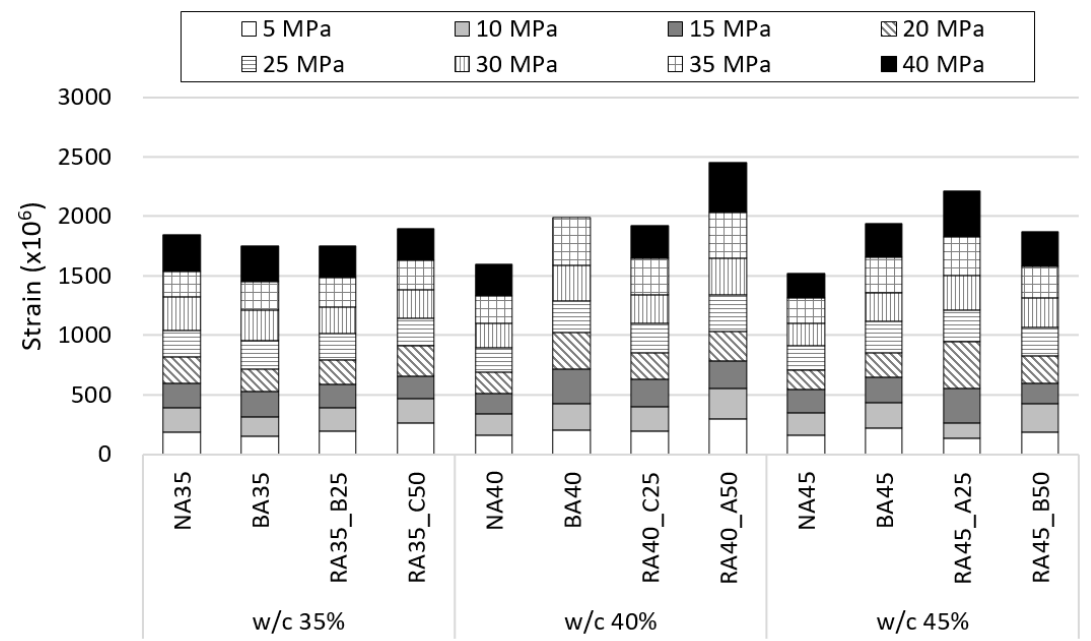
Figure 8. Strain of concrete specimens according to stress.